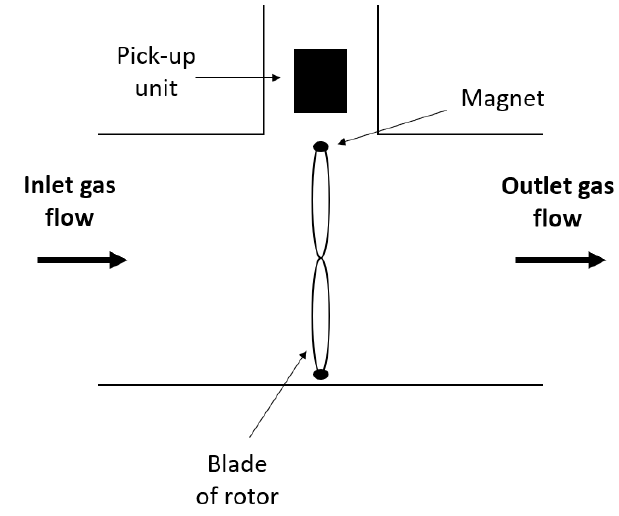
Figure 9. Schematic drawing of an inductive turbine flow sensor.